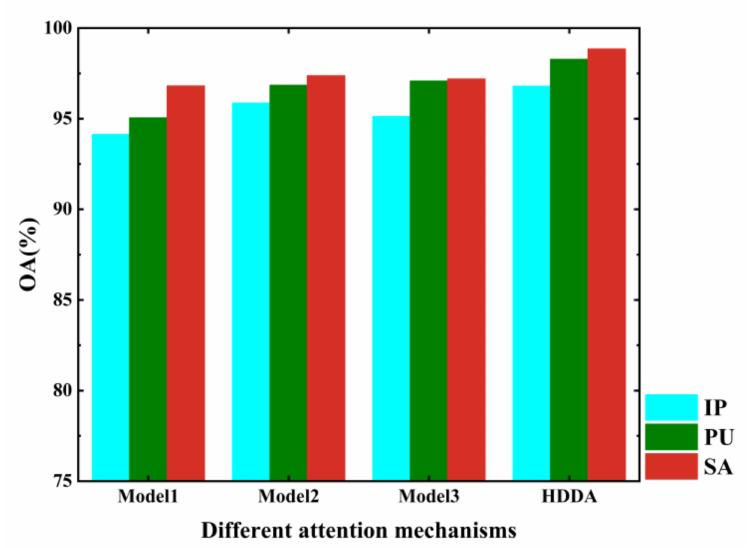
Figure 17. Comparison of OA using four attention mechanisms for three